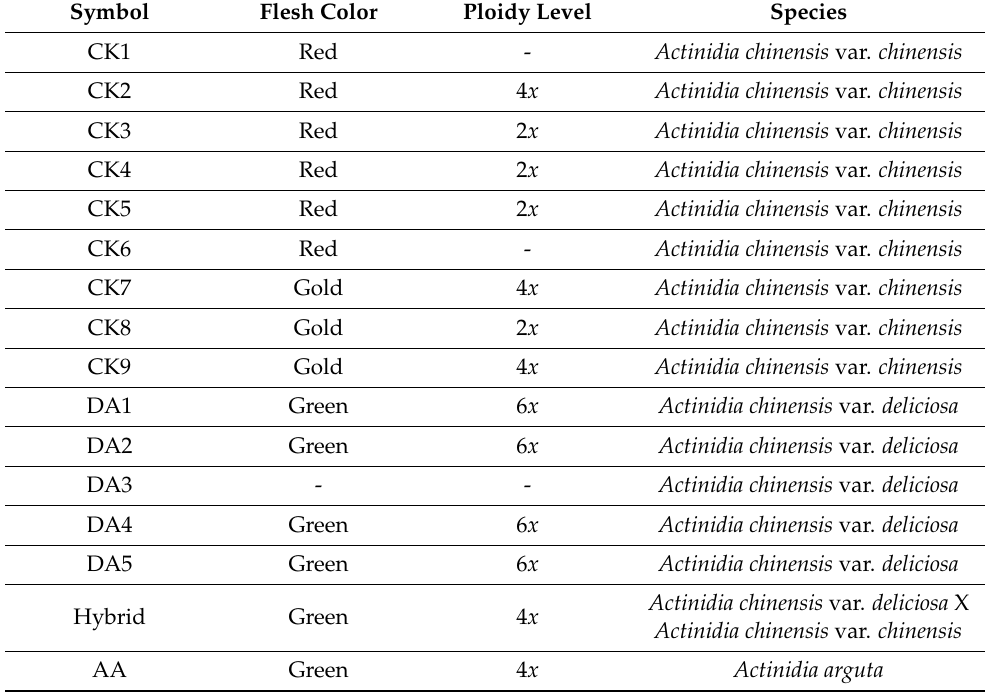
Table 1. List of kiwifruit genotypes and their